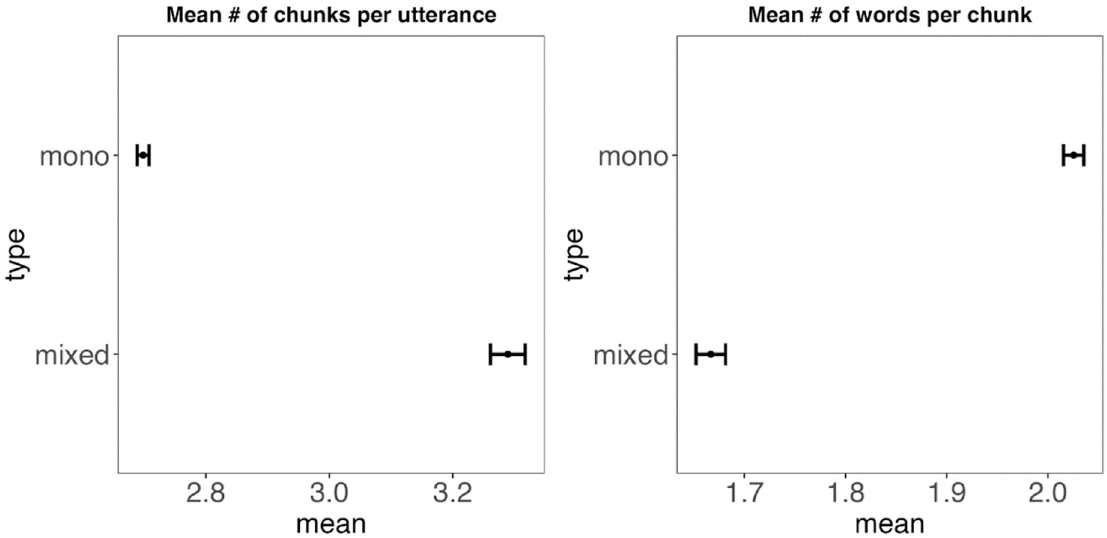
Figure 4. Mean number of chunks per utterance and mean number of words per chunk in the code-mixed vs. monolingual data. The error bars show the standard error.